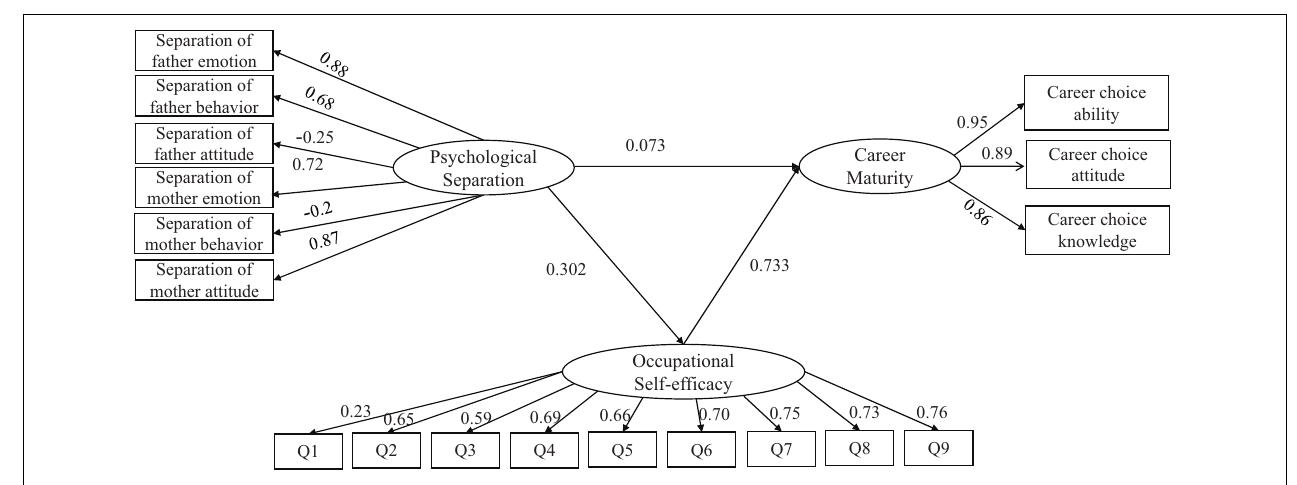
FIGURE 2 | The mediating effect of occupational self-efficacy between psychological separation and career maturity.